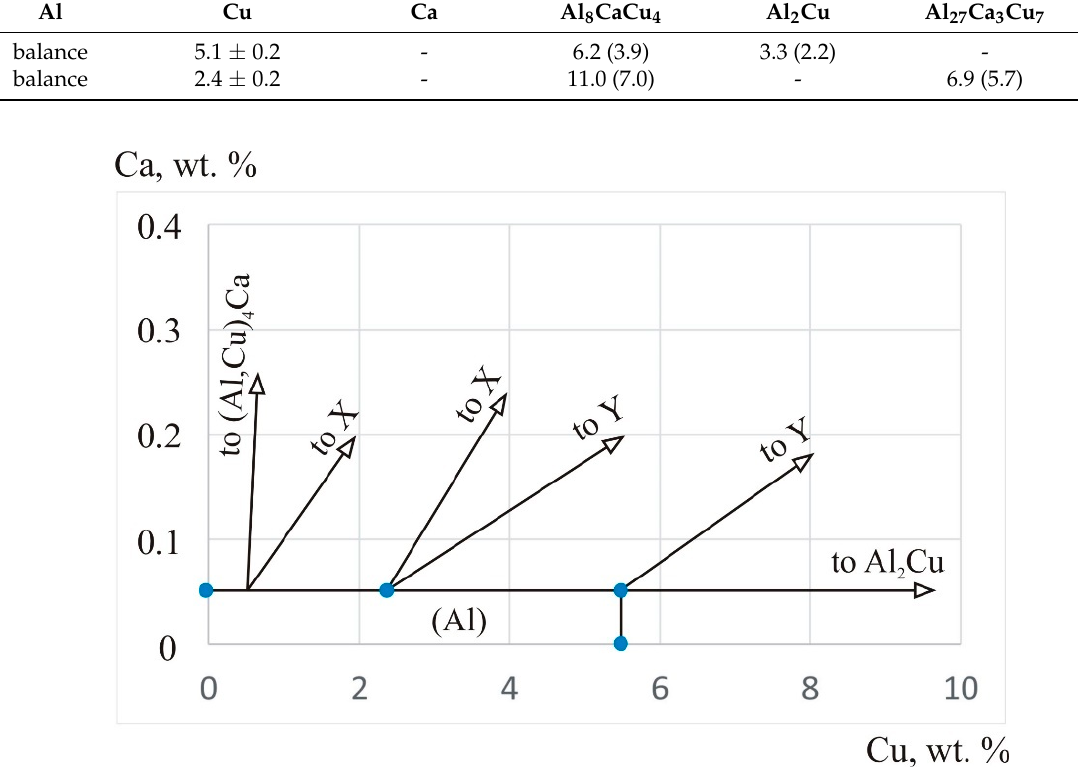
Figure 10. Isothermal section of the Al-Ca-Cu system in the Al-rich corner at 530 °C. X is the Al 27 Ca 3 Cu 7 phase and Y is the Al 8 CaCu 4 phase.